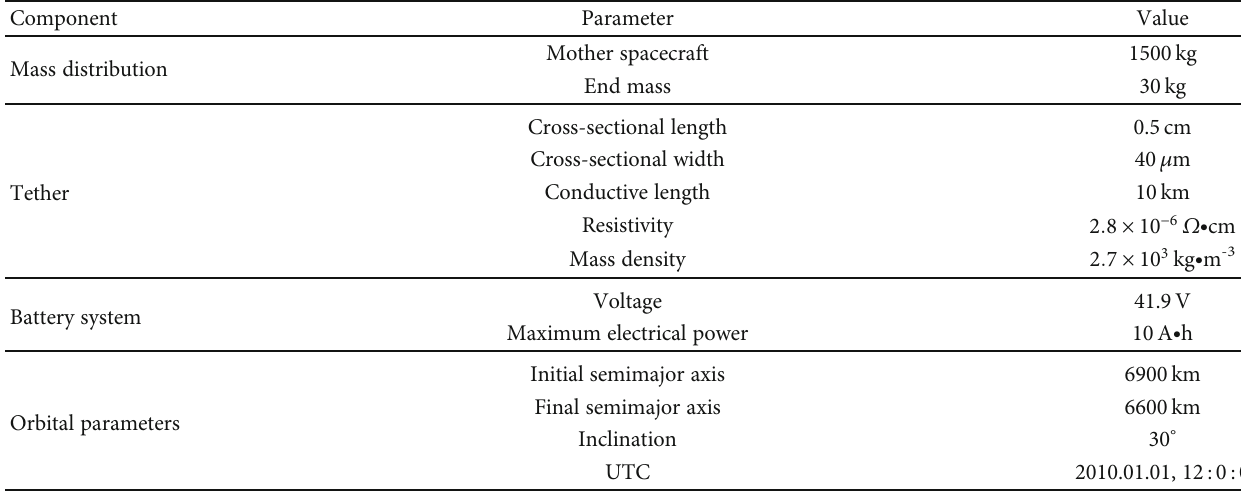
Table 1: Basic input parameters.